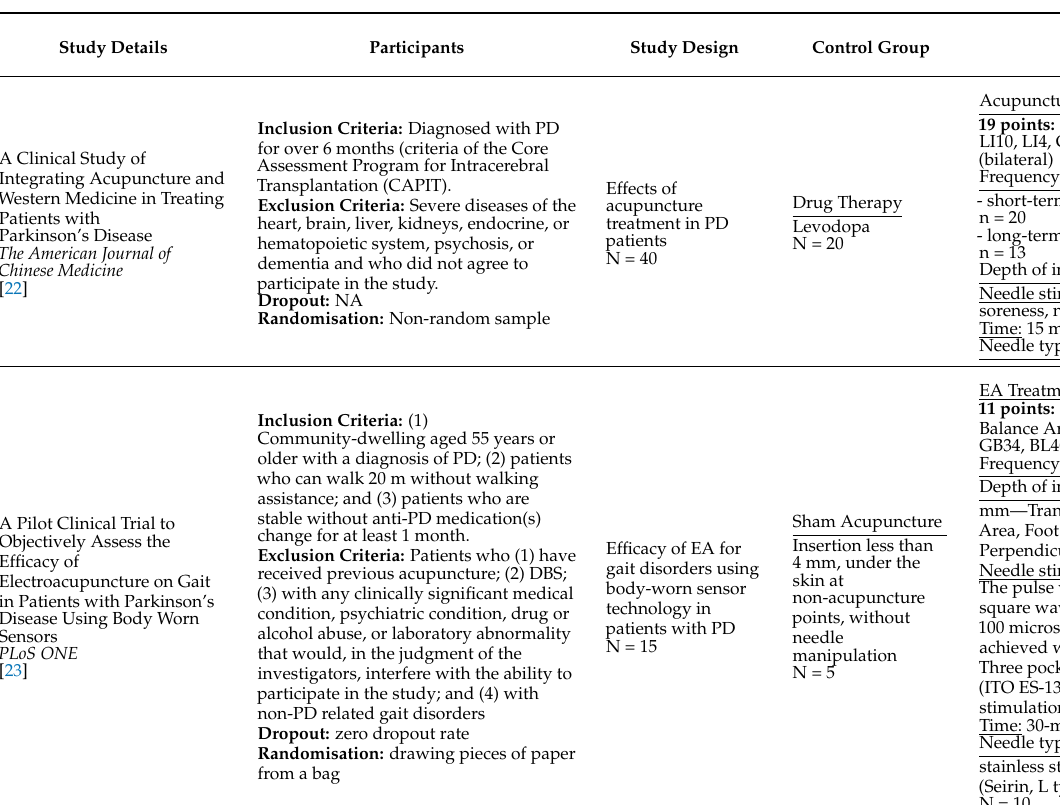
Table 1. Collected data (Legends: NA = not applicable; EA = electroacupuncture; PD = Parkinson’s disease; fMRI = functional magnetic resonance